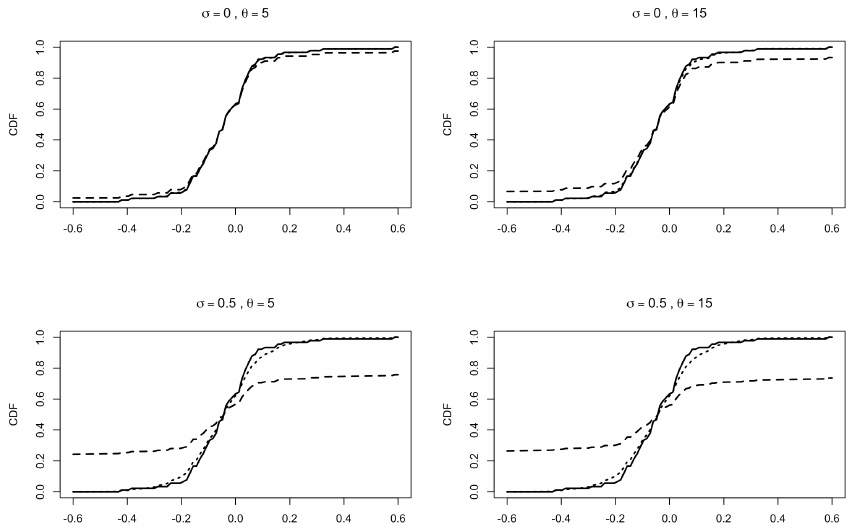
Figure 3. Predictive CDFs for the relative changes in larcenies between 1991 and 1995 (relative to 1991) for the 90 most populous US counties; data taken from Section 2.1 of [34]. Raw data, without rounding. Here, n = 90 and k = 36. Solid line: empirical CDF. Dotted line: predictive CDF from (33). Dashed line: predictive CDF from PS2 with H = T 2 α correspond to different values of θ and σ . In all the plots, the predictive CDFs are evaluated with µ 0 = 0, α 0 = 0.1, β 0 = 0.1 and k 0 =